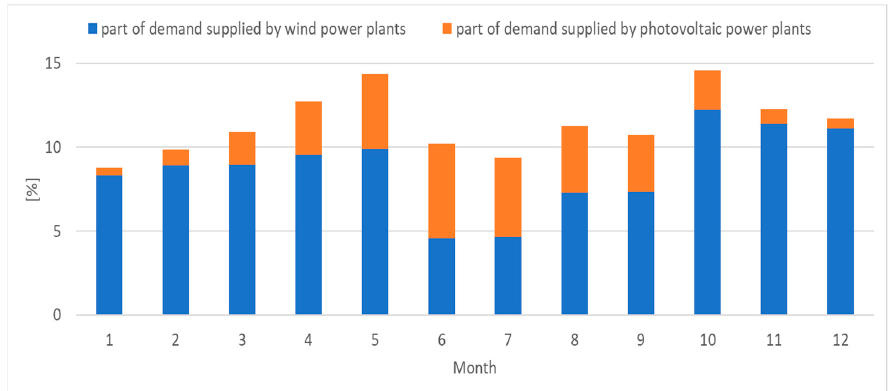
Figure 8. Coverage of power demand by photovoltaic and wind power plants in monthly values in Poland in 2021 (own compilation of data from PSE S.A.).